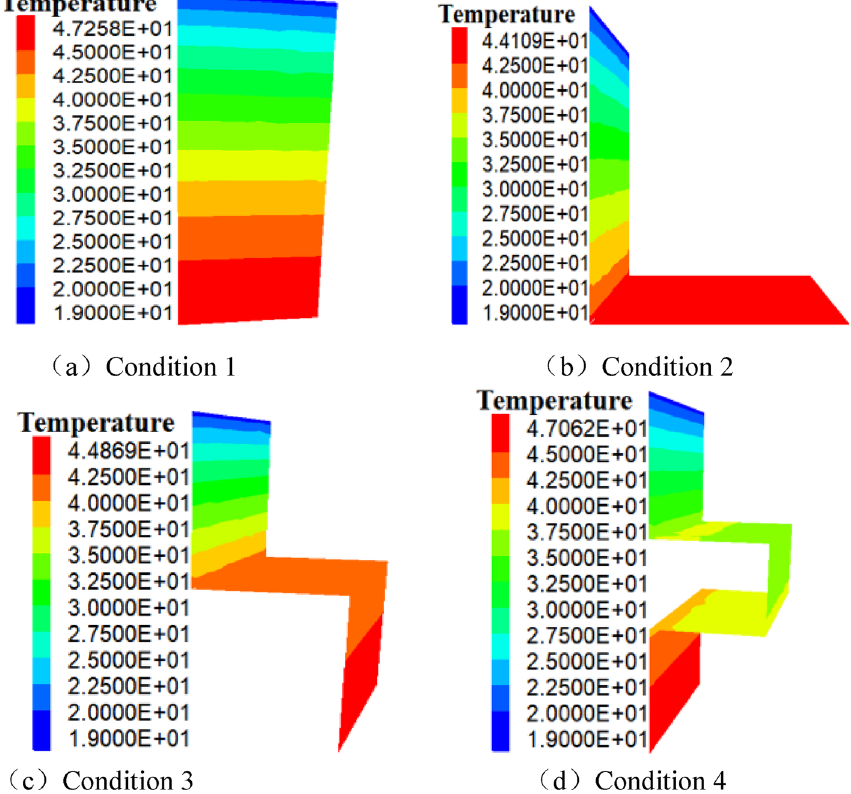
Figure 4. Temperature field of fractured surface water flow (unit: